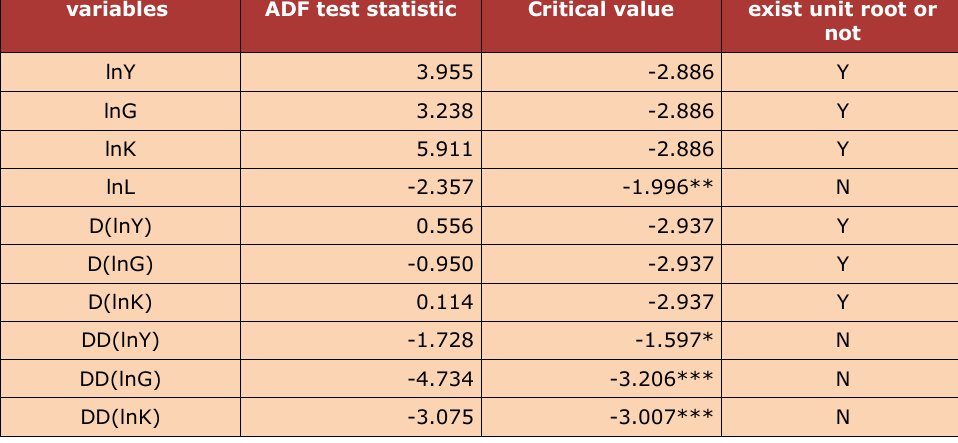
Table 1. ADF unit root test